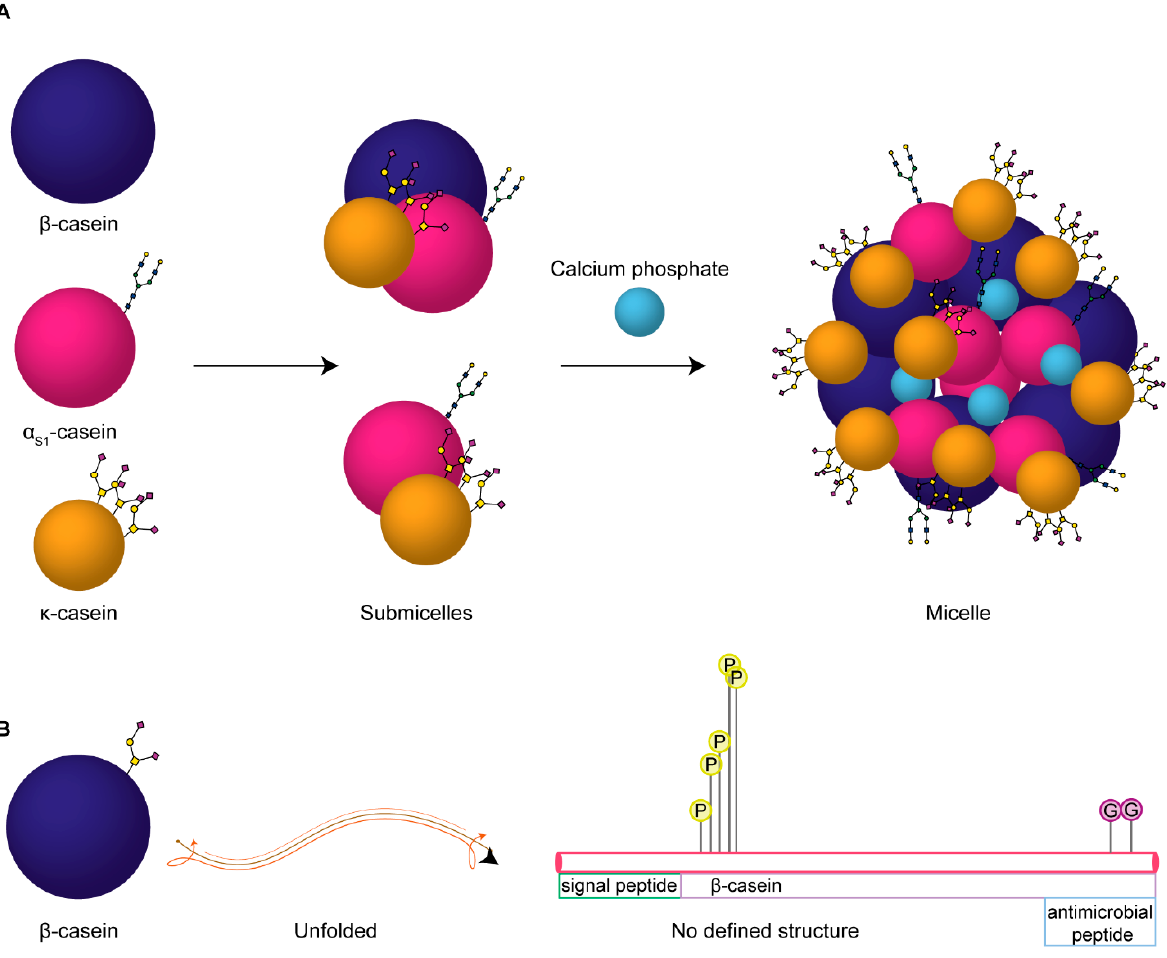
Figure 1. Proposed build-up of human milk casein micelles and proteoforms of casein proteins. ( A ) The three casein proteins in human milk, β -casein (dark purple), α S1-casein (magenta), and κ -casein (gold) are depicted according to their size and with known glycan structures annotated (as N - or O -glycans). These together interact to form submicellar particles, which constitute the building blocks of the casein micelles held together by colloidal calcium phosphate nanoclusters (light blue). ( B ) Our novel observation of β -casein as an O -glycoprotein, depicted as a spherical and unfolded structure. Lollipop depictions of the PTMs identified are shown on the relative sequence of the protein, where P indicates a phosphorylated residue and G indicates the newly discovered O -glycosylated residues; the height of the lollipop depictions is proportional to the relative abundances of the modifications identified on these sites.